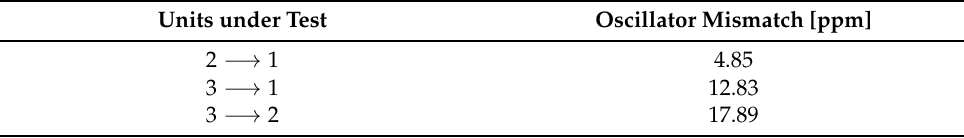
Table 2. Oscillator mismatch between each pair of